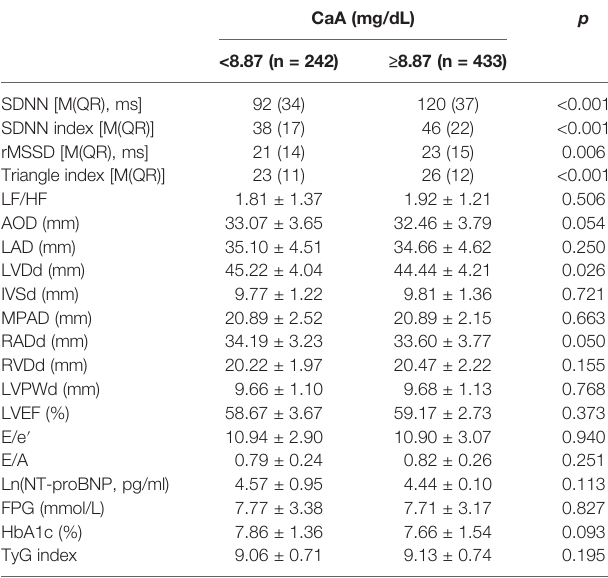
TABLE 5 | Relationship of serum calcium with HRV and cardiac function in T2DM